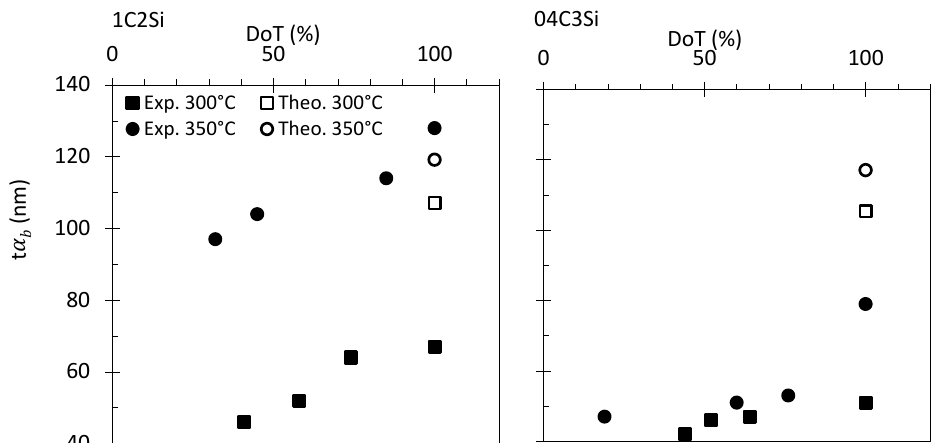
Figure 3. Bainitic ferrite plate thickness, t α b , as a function of the degree of transformation (DoT). Exp. and Theo. stand for experimental and theoretical values as described in the text.